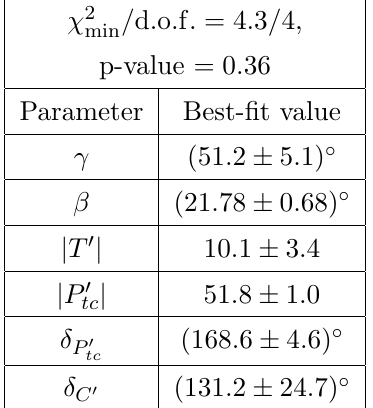
Table 6 . (cid:31) 2 = d : o : f : and best-(cid:12)t values of unknown parameters in amplitudes of eq. (2.1). Con- min straints: B ! (cid:25)K data, measurement of (cid:12) , theoretical inputs j C 0 =T 0 j = 0 : 5, P 0